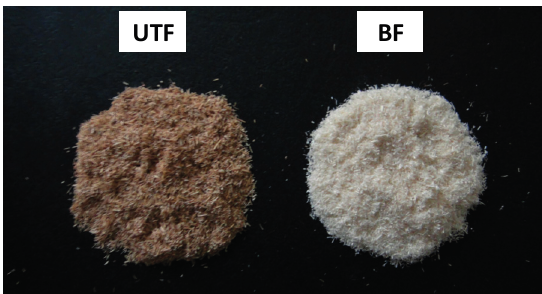
Figure 1. Optical images of untreated fiber (UTF) and bleached fiber